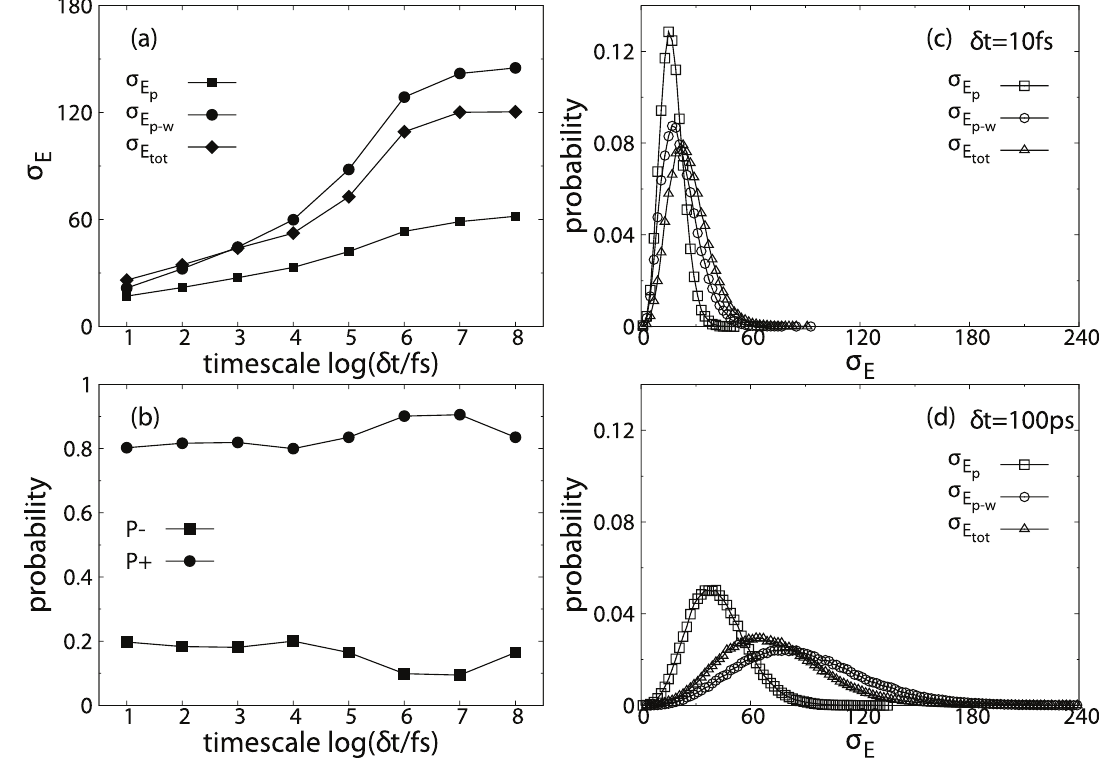
Figure 2. Standard deviations ( s , in the unit of kcal / mol , the same unit is used for all the following text, figures and the supporting information) for various potential energy terms of barstar. (a) s E being larger than or equal to ( P z , cycle) and smaller than s E Probability of s E tot (triangle) for d t ~ 10 fs . (d) Distributions of s E